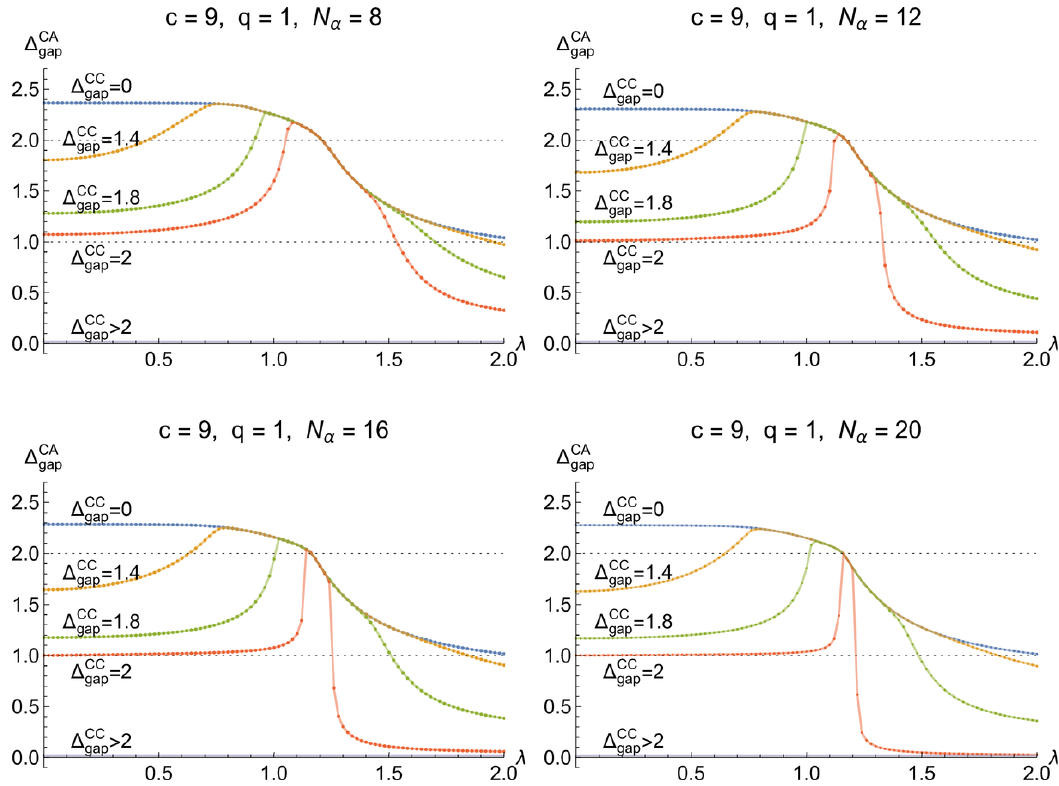
from the numerical bootstrap, in the gap